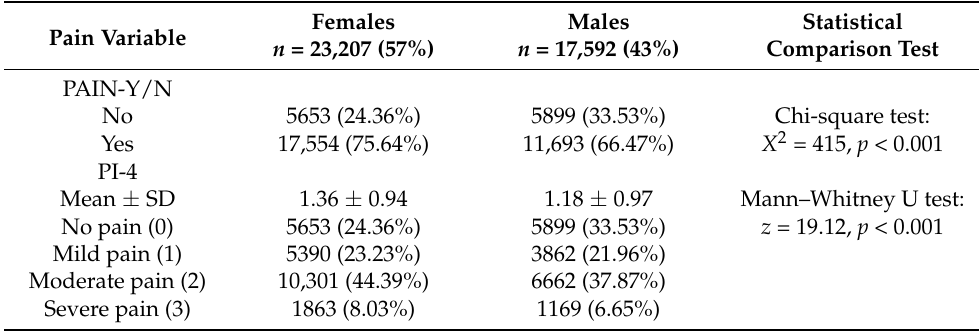
Table 3. Comparisons for dichotomous pain (PAIN-Y/N) and four-point pain scale (PI-4) between males and females with hypertension (cases, n = 40,799).